Question: Condense the content of this figure into a single sentence.
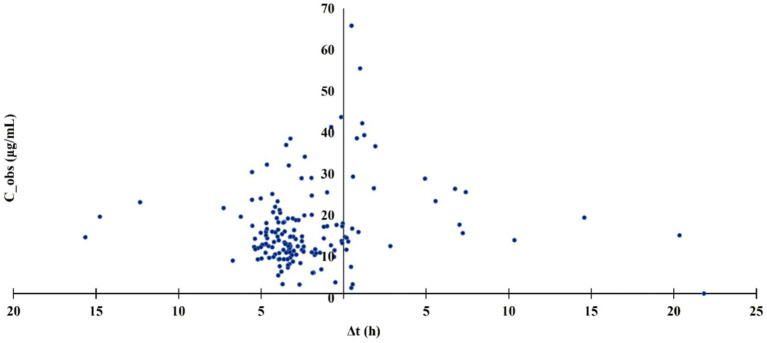
Answer: Scatter plot of C_obs vs. Δt ( n = 160).